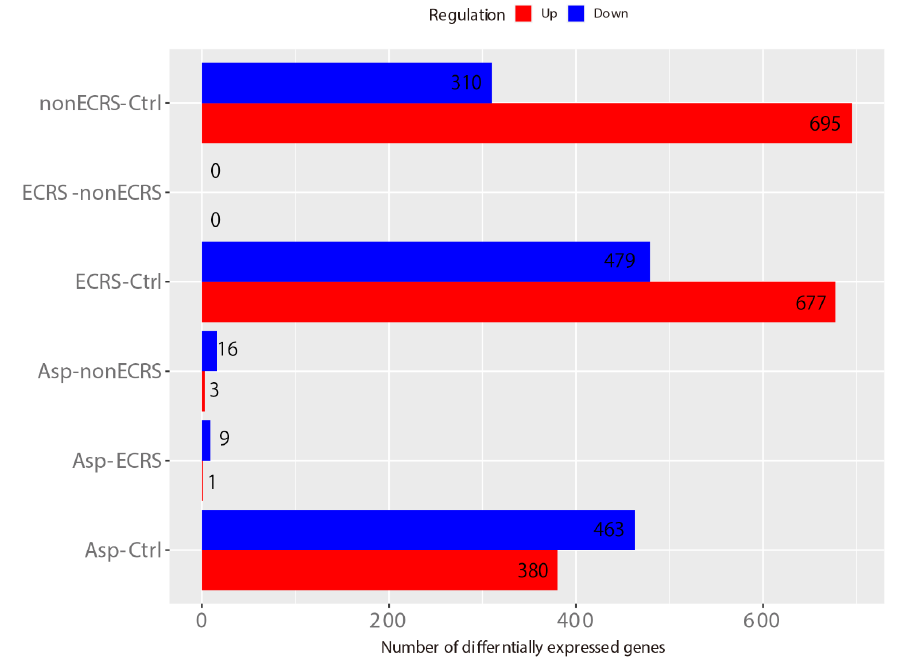
Figure 3. DEGs in ECRS vs. control (ECRS-Ctrl), 677 upregulated and 479 downregulated; nonECRS vs Ctrl (nonECRS-Ctrl), 695 and 310; Asp vs Ctrl (Asp-Ctrl), 380 and 463; Asp vs nonECRS (Asp-nonECRS), 3 and 16; and Asp vs ECRS (Asp-ECRS), 1 and 9. No DEGs were identified in ECRS vs nonECRS (ECRS-nonECRS). However, a Venn diagram of all CRSwNP groups vs control showed the existence of specific DEGs in each CRSwNP group (Figure 4).